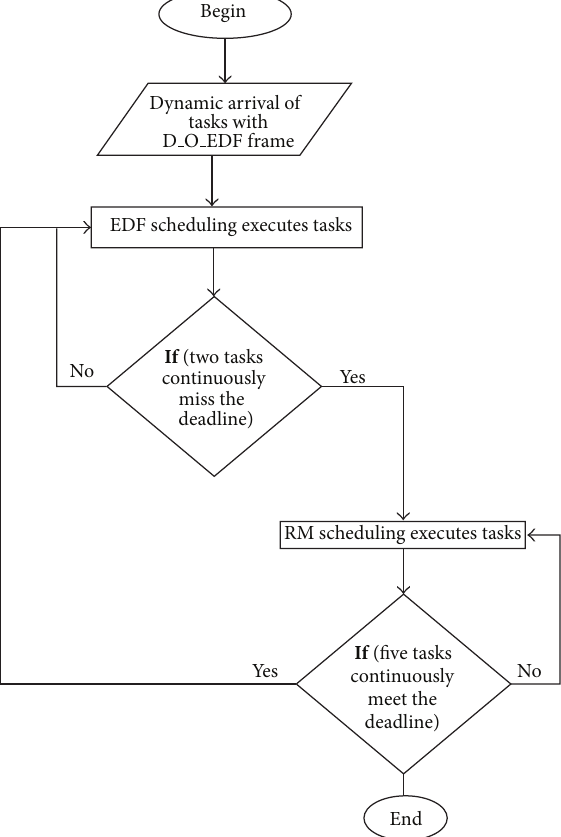
Figure 7: D R EDF scheduling algorithm